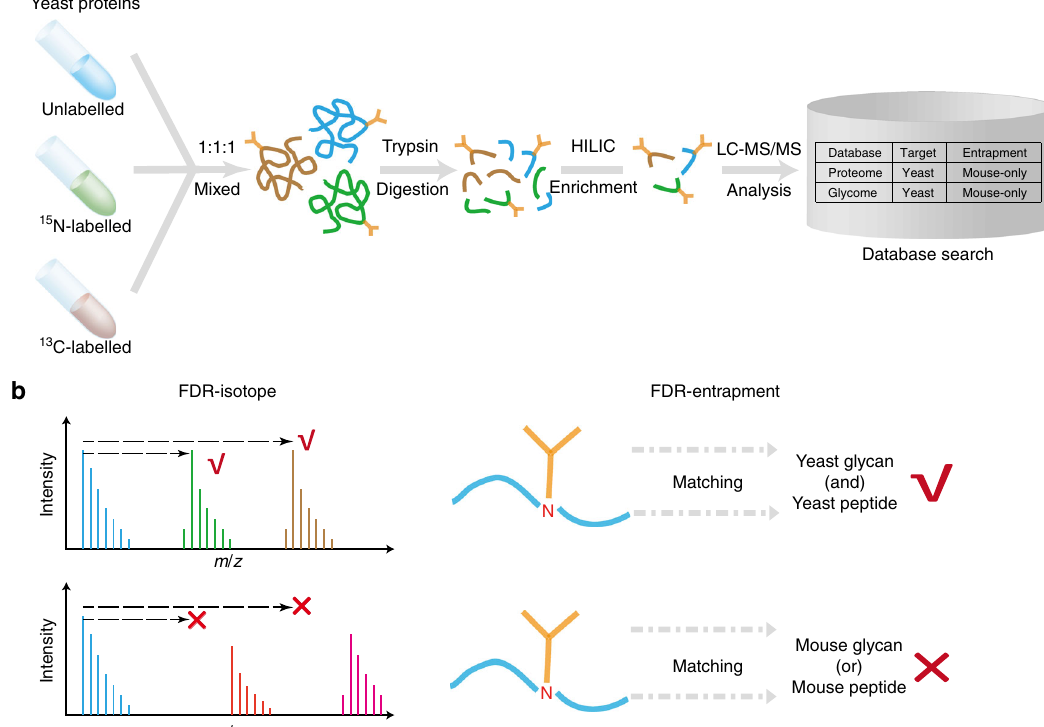
Fig. 4 FDR validation work fl ow. a Validation work fl ow. b Two search engine-independent FDRs using information from isotope labeling and an entrapment database,